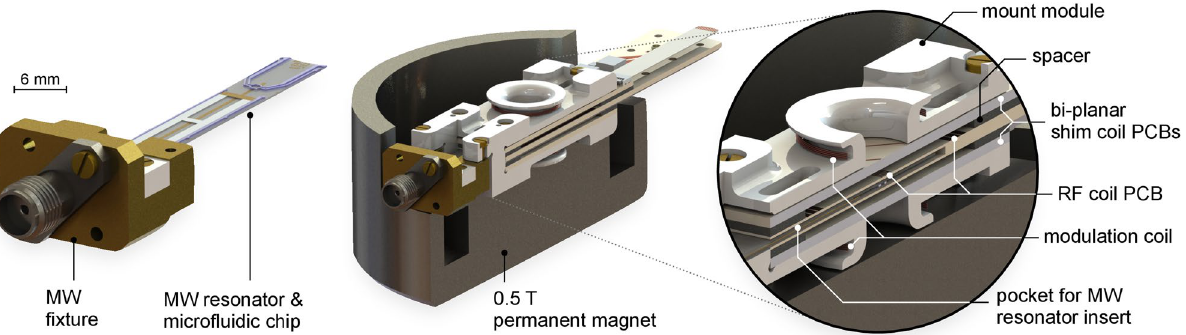
Figure 1. Computer aided design (CAD) views of the ODNP probe inside a palm-sized permanent magnet. The microfluidic chip features a sample reservoir and a MW resonator. A stacked figure-8 type RF transceive coil accepts the sample container and is sandwiched between a set of bi-planar electrical shim coils. A B 0 -field modulation coil is part of phase sensitive EPR detection. Figure used with permission 41